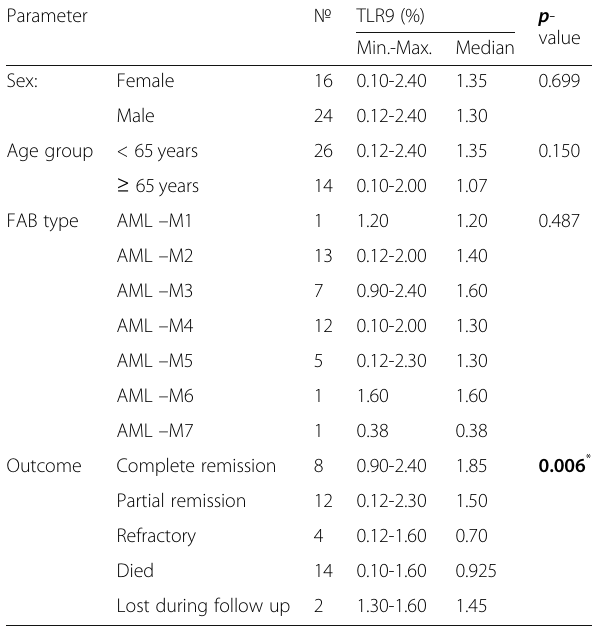
Table 2 The median of TLR9 expression in relation to some parameters in AML patients